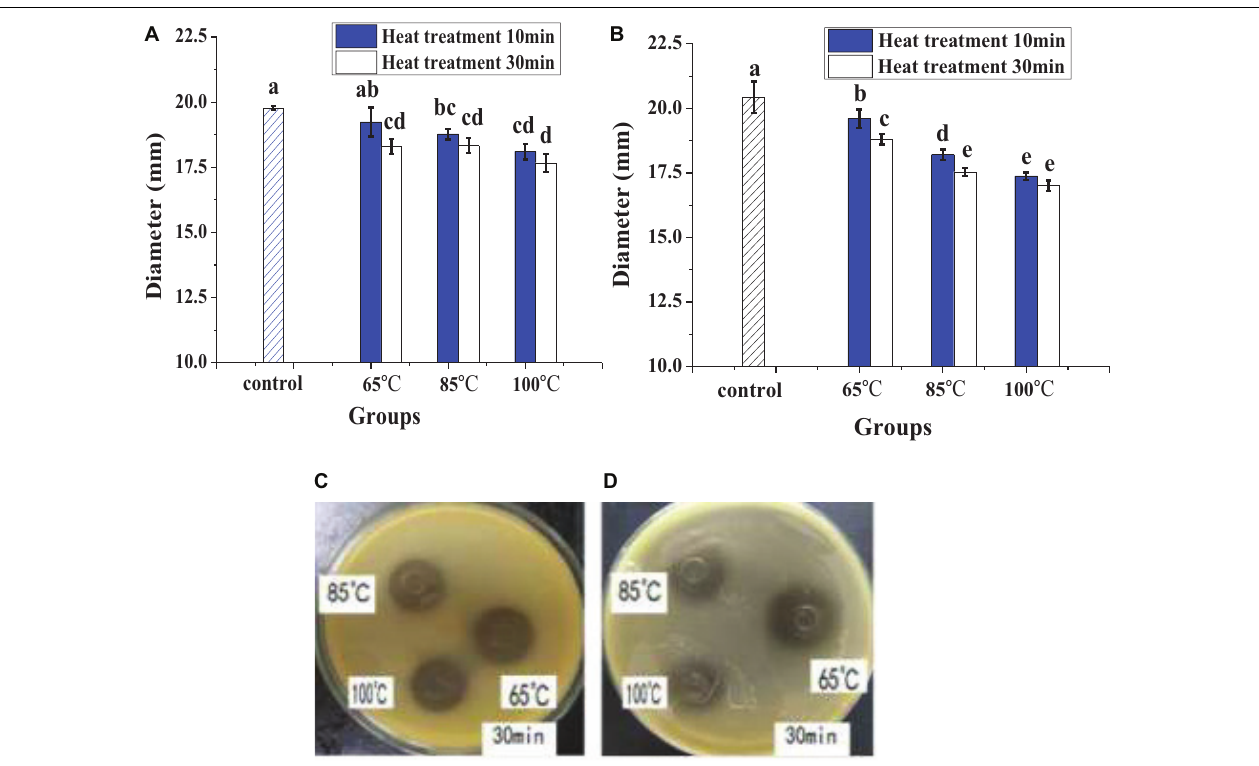
FIGURE 1 | The effects of heat on antibacterial activity, diameter (mm) refers to the diameter of the inhibition zone around the Oxford cup, which displayed the antibacterial activity, and the description of the diameter also applied to the following figure. The bactericidal effect against E. coli (A) and against S. aureus (B) , in which different lowercase letters meant that the bactericidal effect was significantly different ( P < 0.05). The photographs of heat treatment effects on antibacterial activity against E. coli (C) and against S. aureus (D) at different temperatures for 30 min.